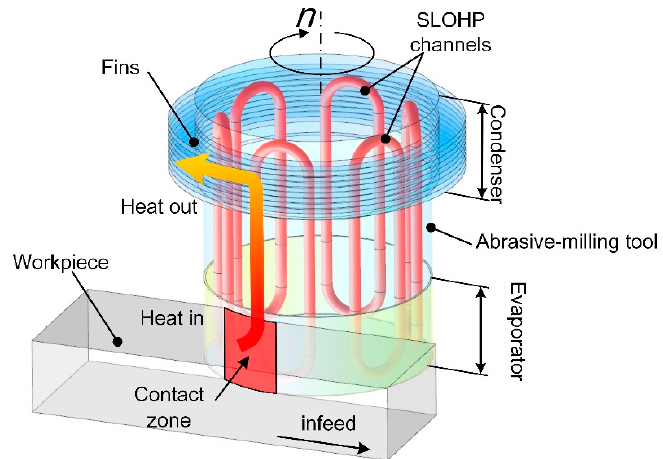
Figure 1. Illustration of an OHP abrasive-milling tool.